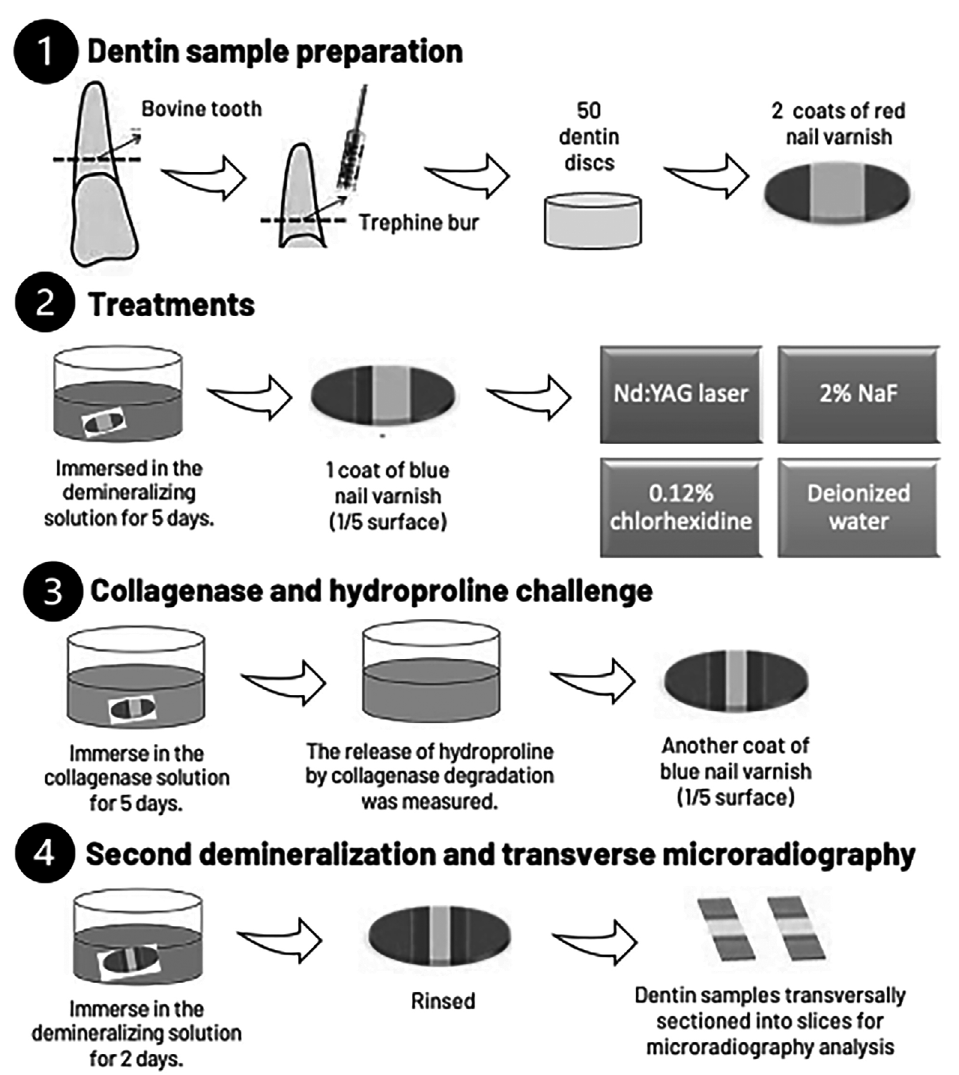
Figure 1- Experimental design of the